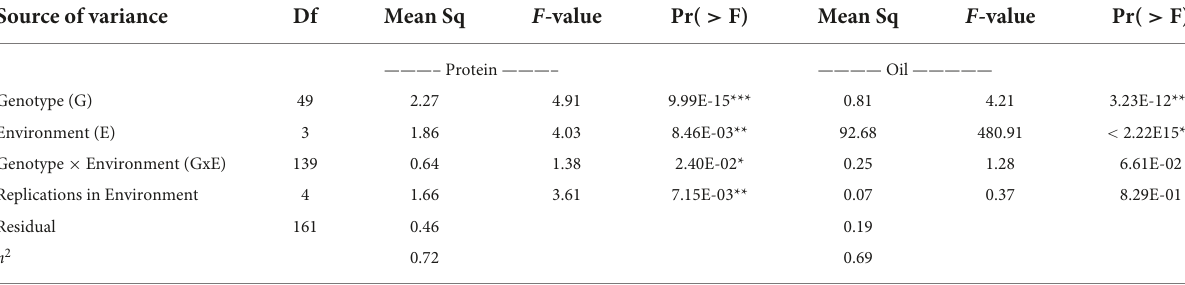
TABLE 3 Analysis of variance summary for seed protein and seed oil with heritability ( h 2 ) on an entry-mean basis. Source of variance Df Mean